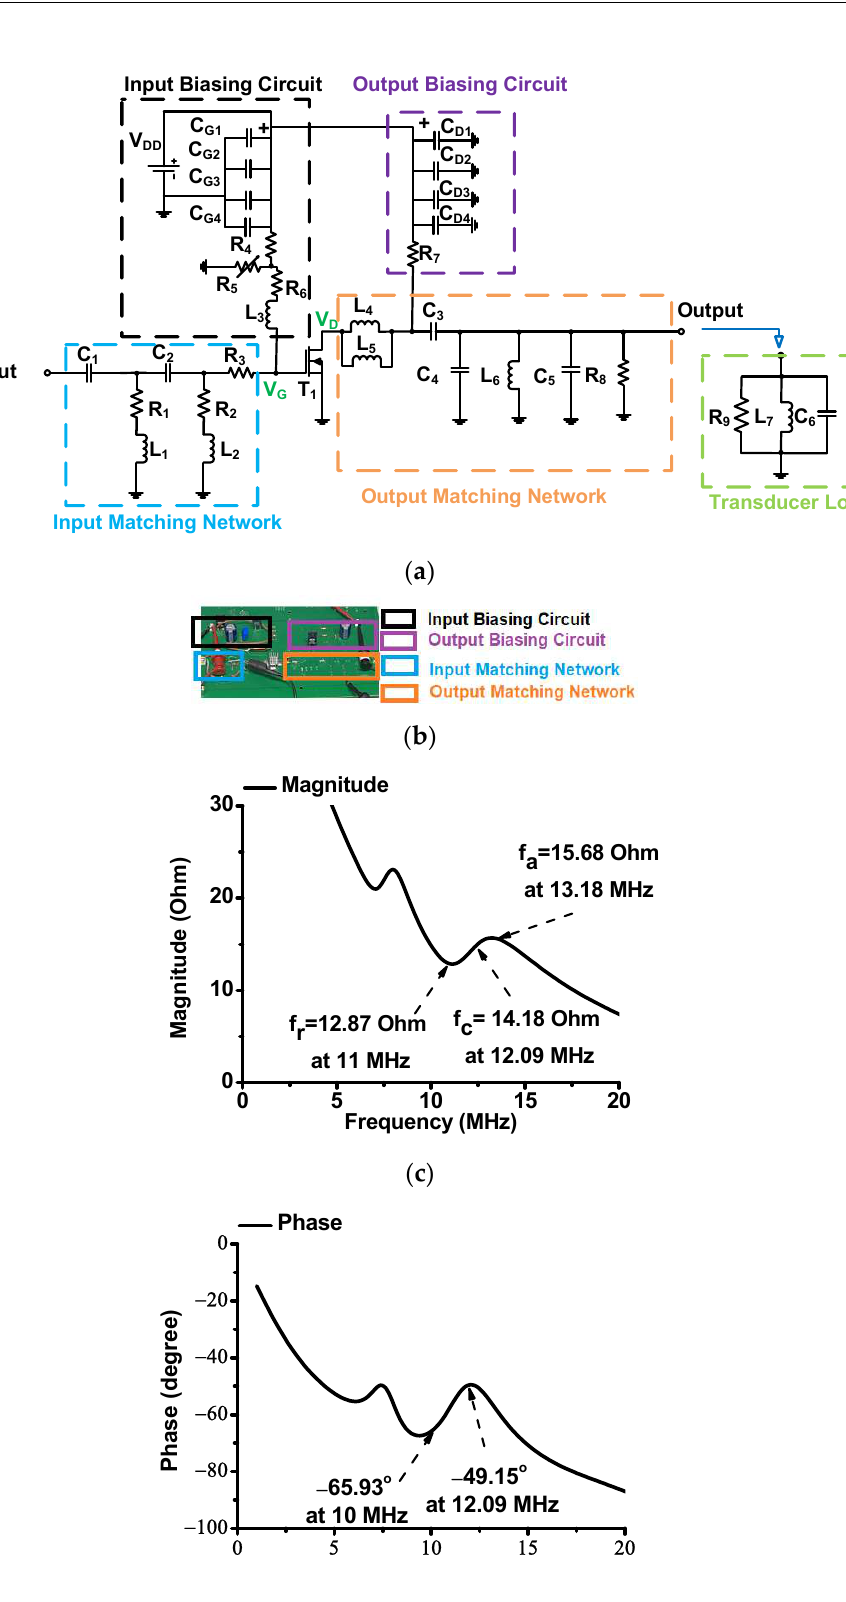
Figure 2. ( a ) Schematic diagram and ( b ) printed circuit board of the designed inverse Class-E power amplifier. ( c ) The magnitude and ( d ) phase of the impedance of the ultrasound transducer. In the input biasing circuit, an electrostatic capacitor (C G1 = 10 µF; Panasonic Corp., Newark, NJ, USA) and three additional capacitors (C G2 = 0.1 µF, C G3 = 1,000 pF, C G4 = 47 pF; KEMET Corp., Simpsonville, CA, USA) were used [61]. A variable resistor (R 5 ; KEMET Corp.) fed the gate bias DC voltage (V G ) through a fixed resistor (R 6 ) and inductor (1 µH,